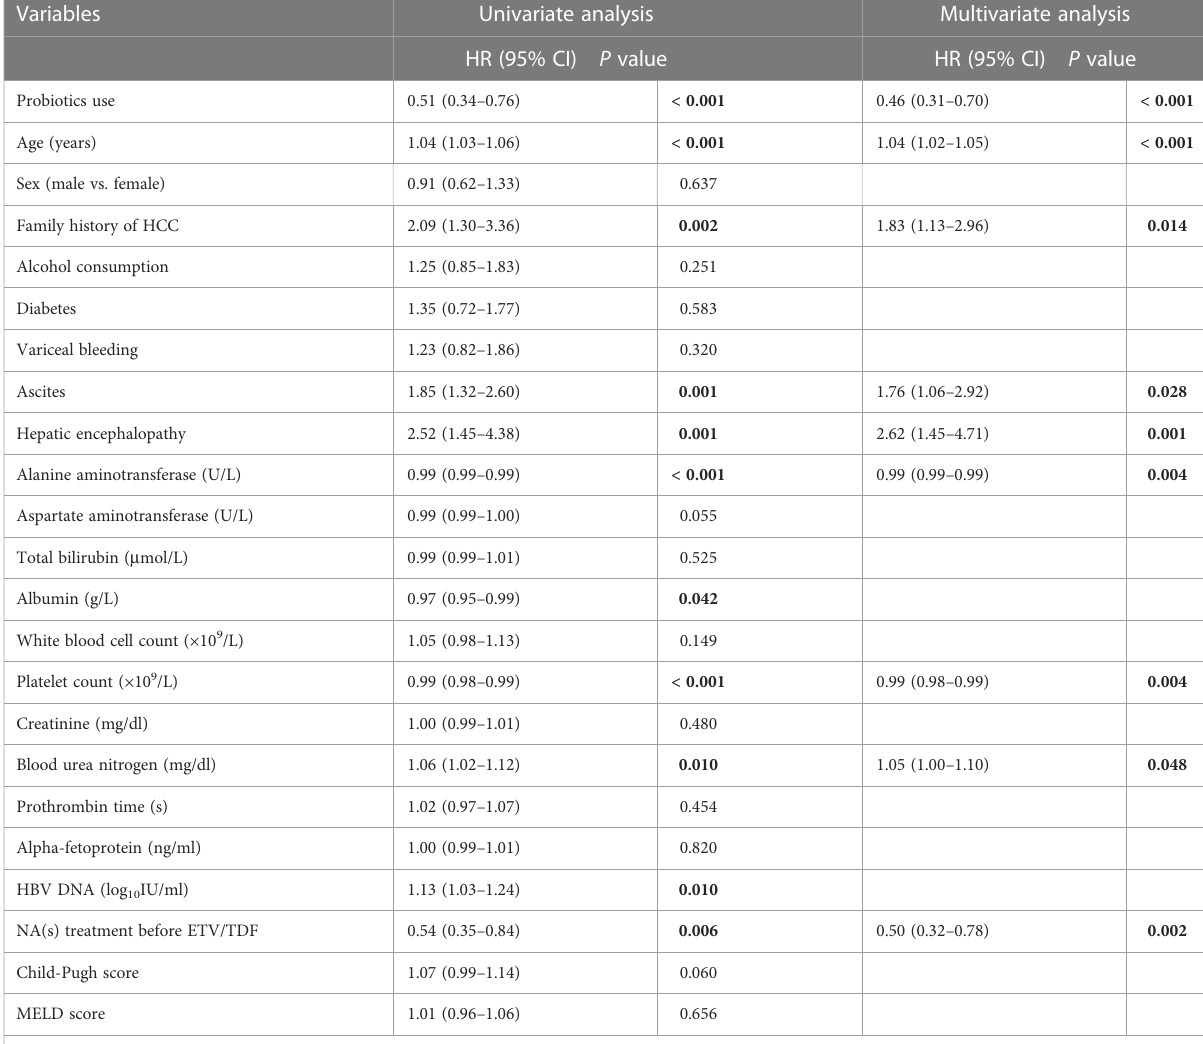
TABLE 2 Cox proportional hazards regression model analysis for risk of HCC in patients with hepatitis B-related cirrhosis.